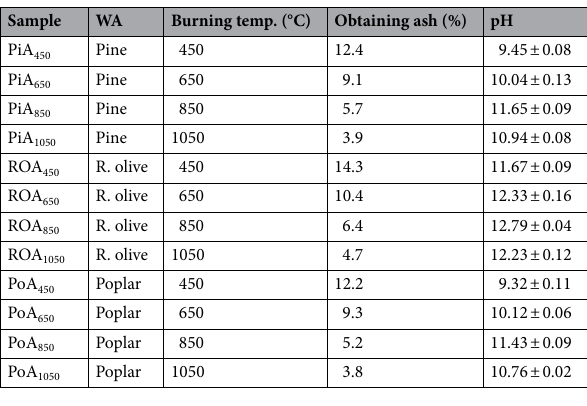
Table 1. Soluble alkalinity of WA catalysts.